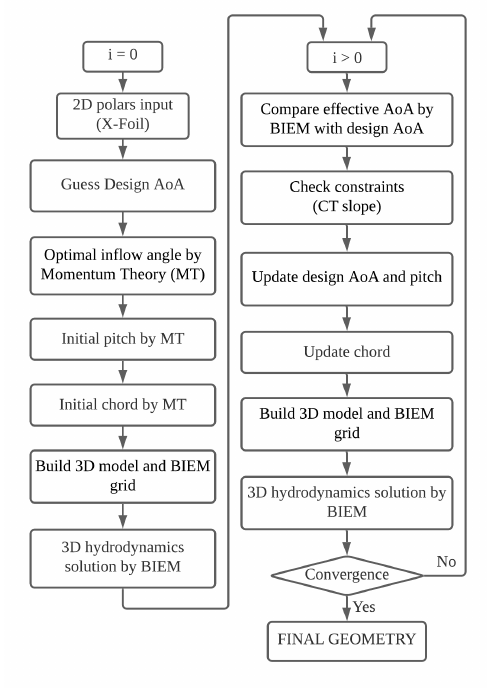
Fig. 3. Design procedure: main steps at start ( i = 0) and during iteration ( i > 0 ).